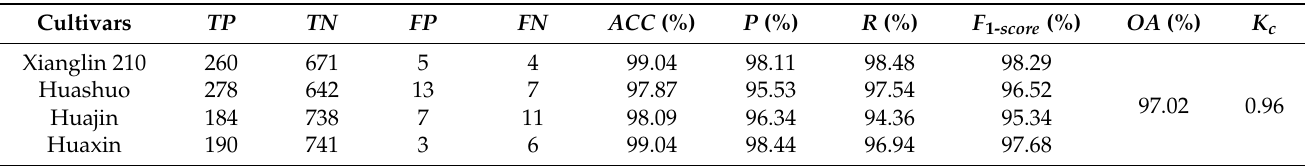
Table 2. Quantitative evaluation results of